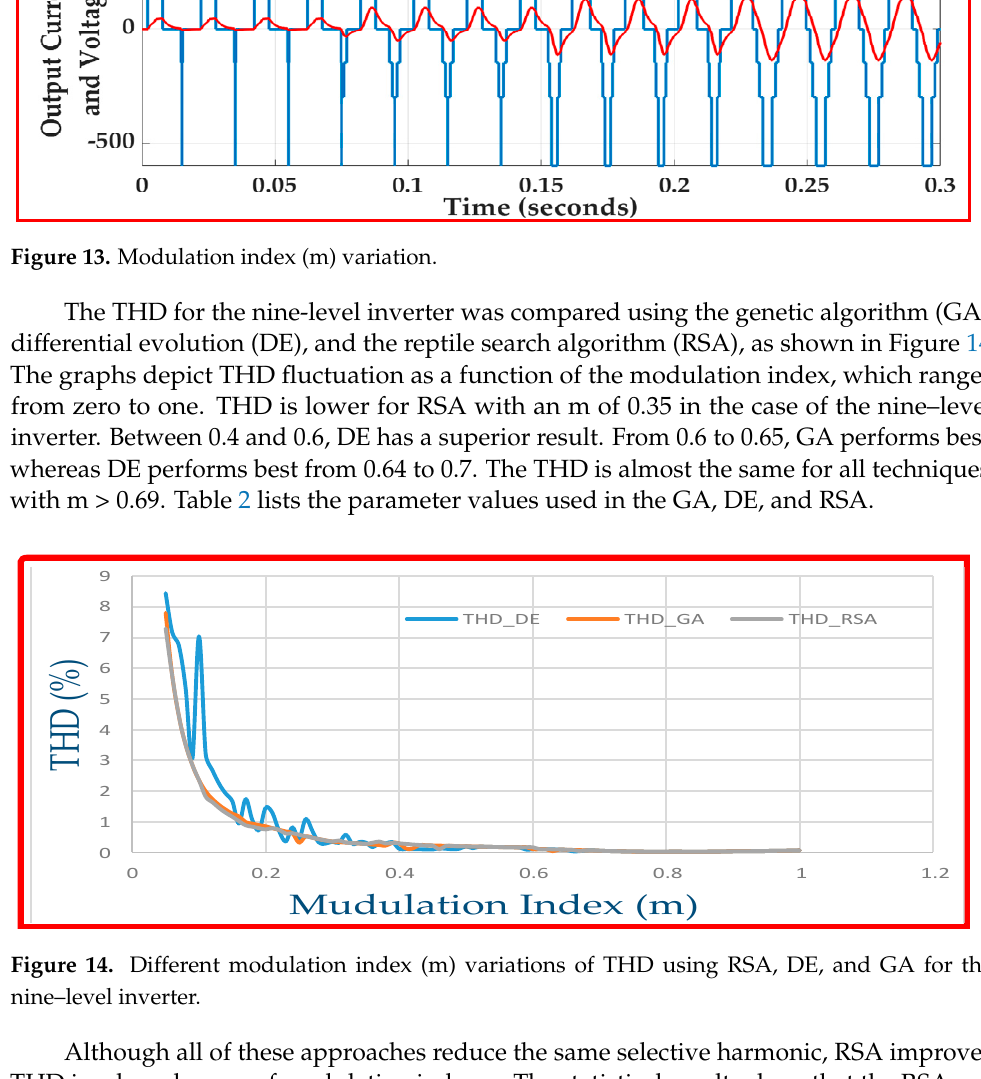
Figure 12. DC voltage source variation.